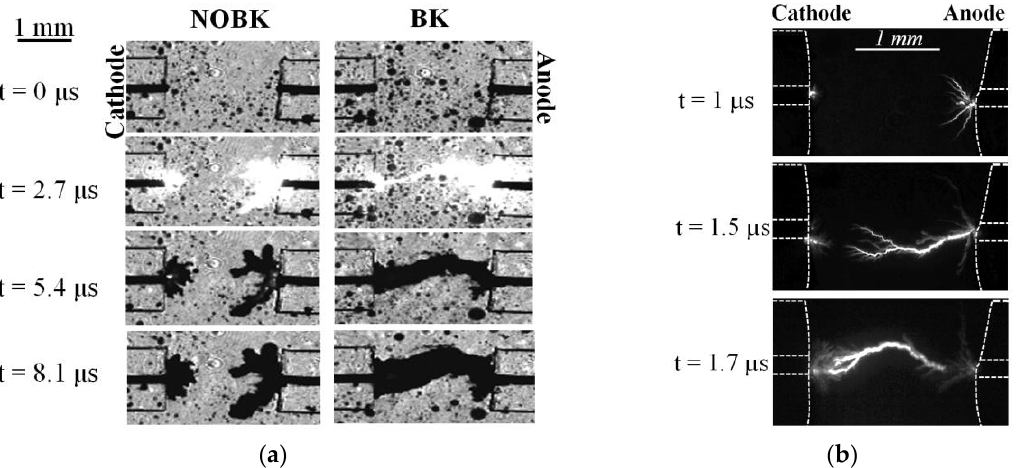
Figure 4. Optical diagnostics of pin-to- pin discharges in Cr(VI) solution (47 mg/L, σ = 4 mS/cm, pH = 2.4) Δt = 500 µs, gap = 2 mm, electrode length = 0 ± 10 µm. ( a ) Time-resolved shadowgraphy of case NOBK and case BK (U = 11 kV; exposure time = 0.37 µs); ( b ) Fast imaging for three successive BK experiments (U = 12.5 kV, exposure time = 100 ns).